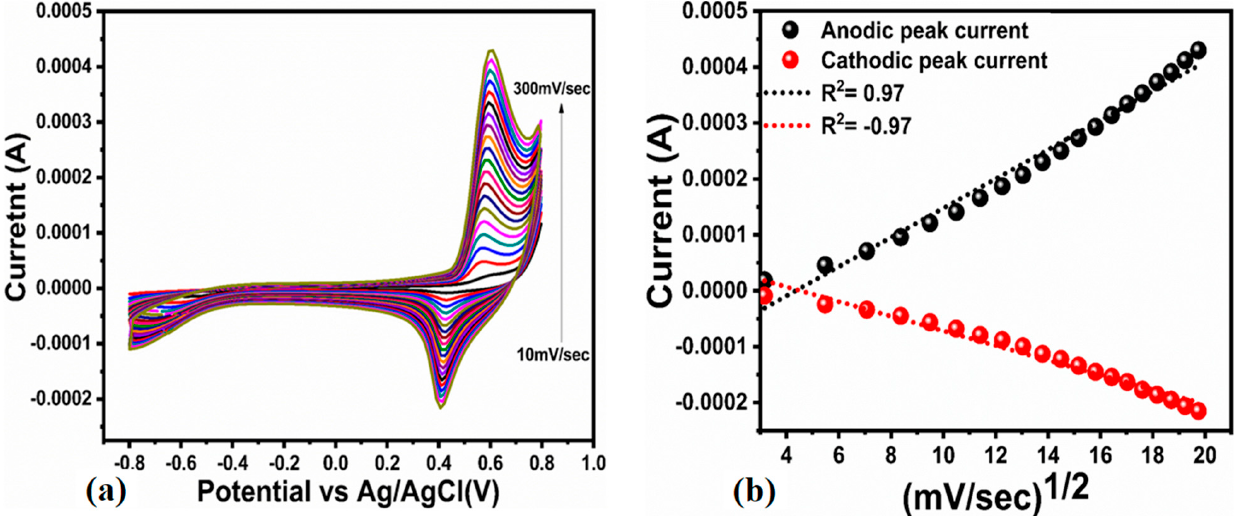
Figure 3. ( a ) Cyclic voltammogram of sample 1 prepared with 10 mL of bitter gourd peel extract at various scan rates in 0.1 mM urea, ( b ) linear plot of anodic and cathodic peak current against square root of scan rate.